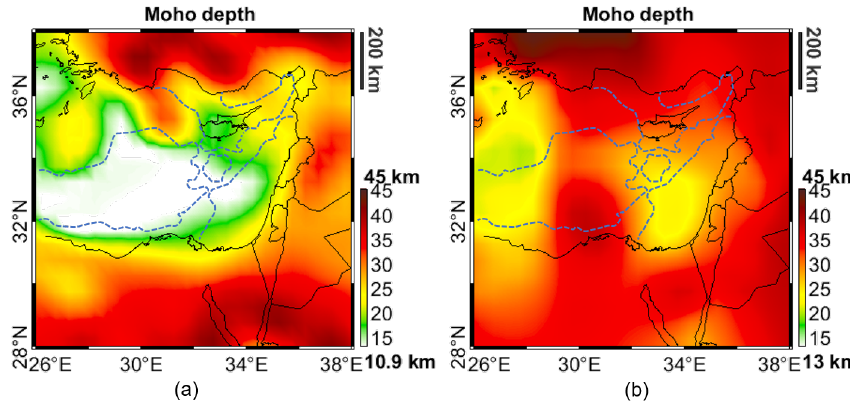
Figure 10. Moho depth interpolated from the GEMMA1.0 model ( a ); Moho depth from the European model ( b ). Dashed blue lines represent the boundary of the main geological provinces.